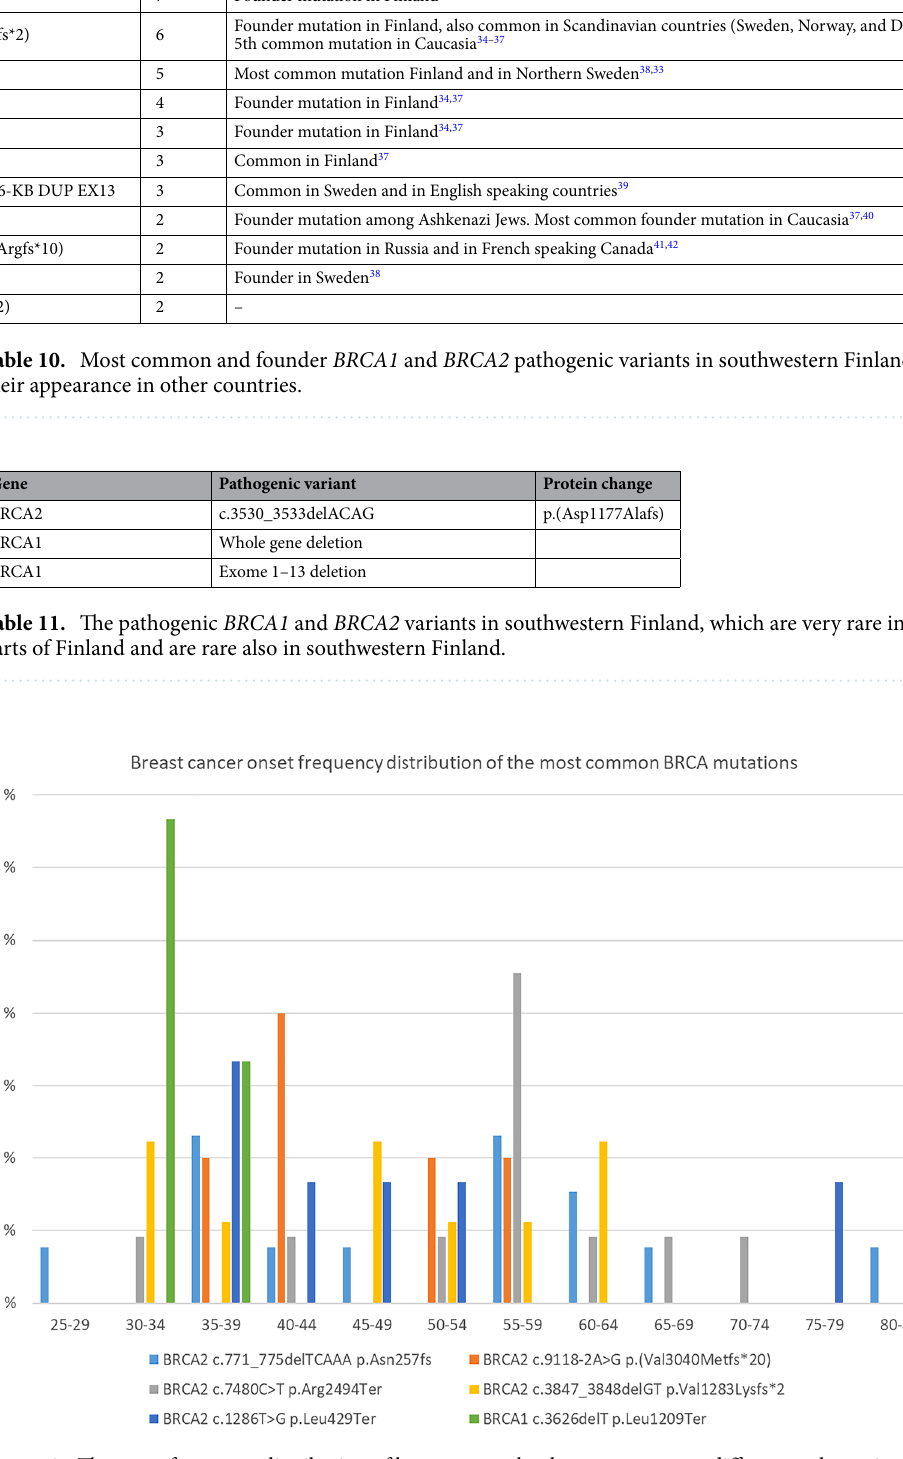
Figure 4. The onset frequency distribution of breast cancer by the most common different pathogenic